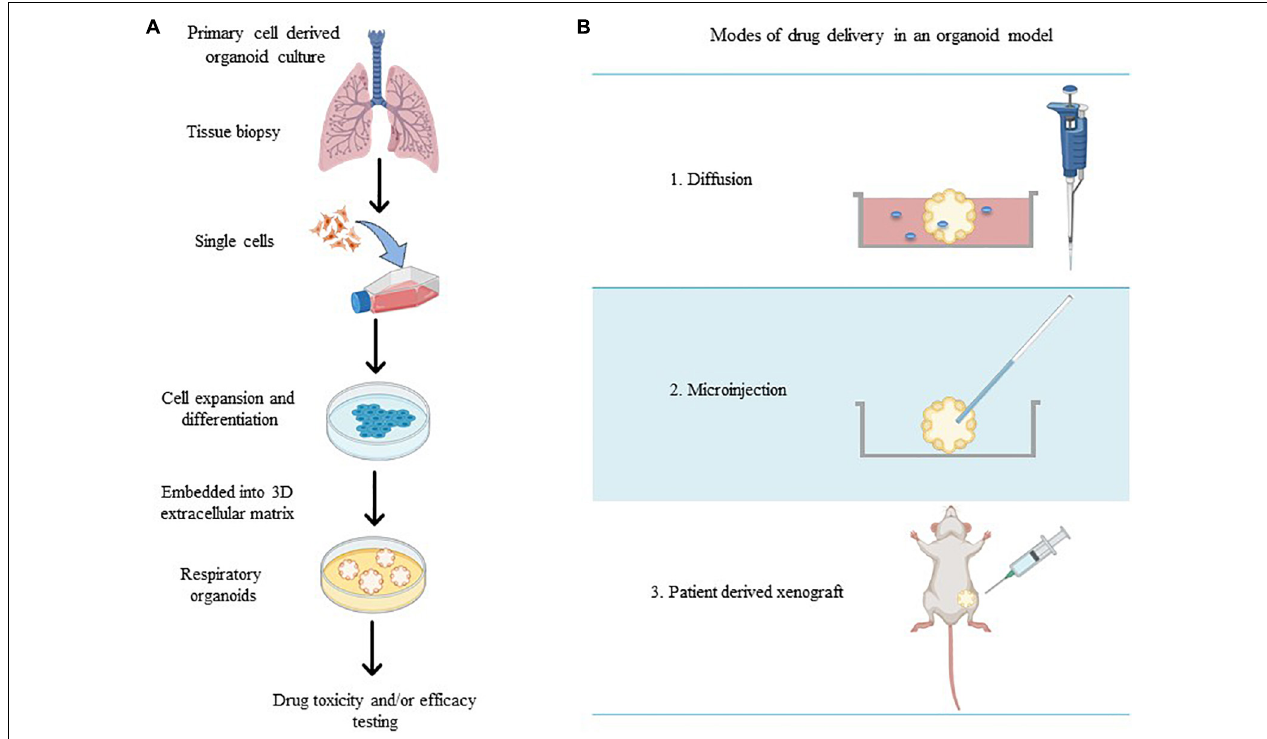
FIGURE 1 | (A) Schematic overview of methods for the generation of respiratory organoid cultures derived from primary lung cells. (B) The varying modes of drug treatment delivery in an organoid model (made in ©BioRender - biorender.com).